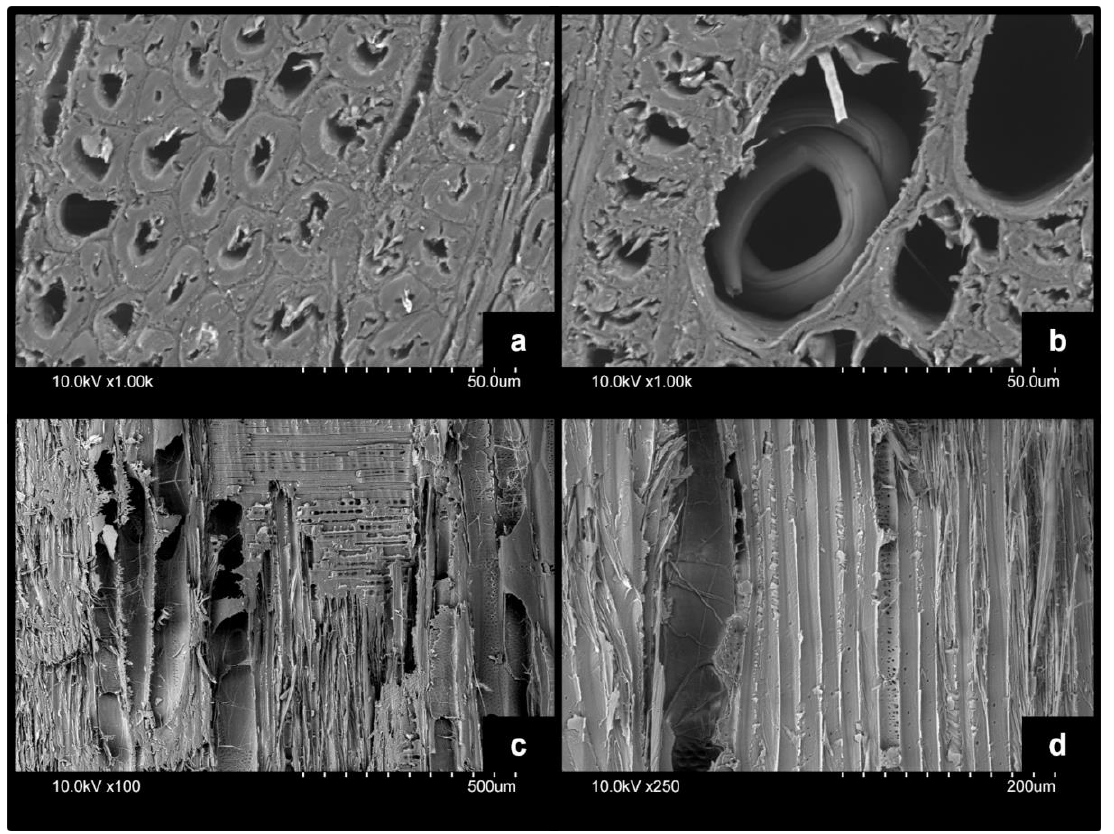
Figure 5. SEM pictures of cross section (above) and longitudinal section (below) of partly decayed acetylated hornbeam stake: ( a ) non-decayed parts with thick cell walls, ( b ) worm in cell lumen, ( c ) disappeared bordered pits, fibrous tissue, ( d ) hyphae in lumen, gradual thinning of cell walls, typical signs of soft rot decay.